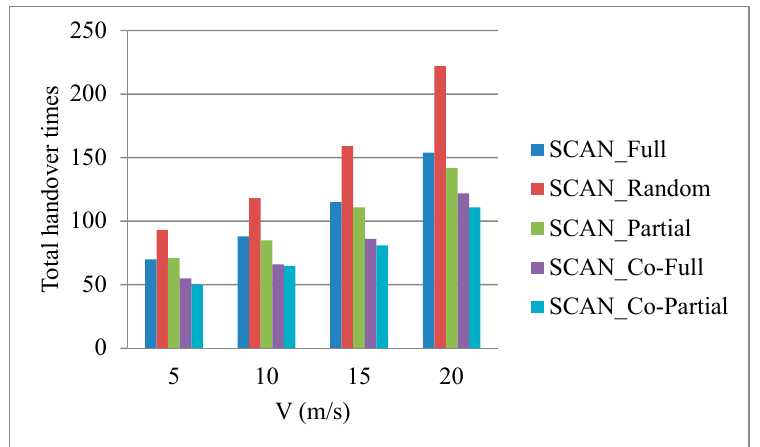
Figure 20. The total number of spectrum handovers under different moving speeds (PU number =10, P PUaccess =0.5, SU number =10).